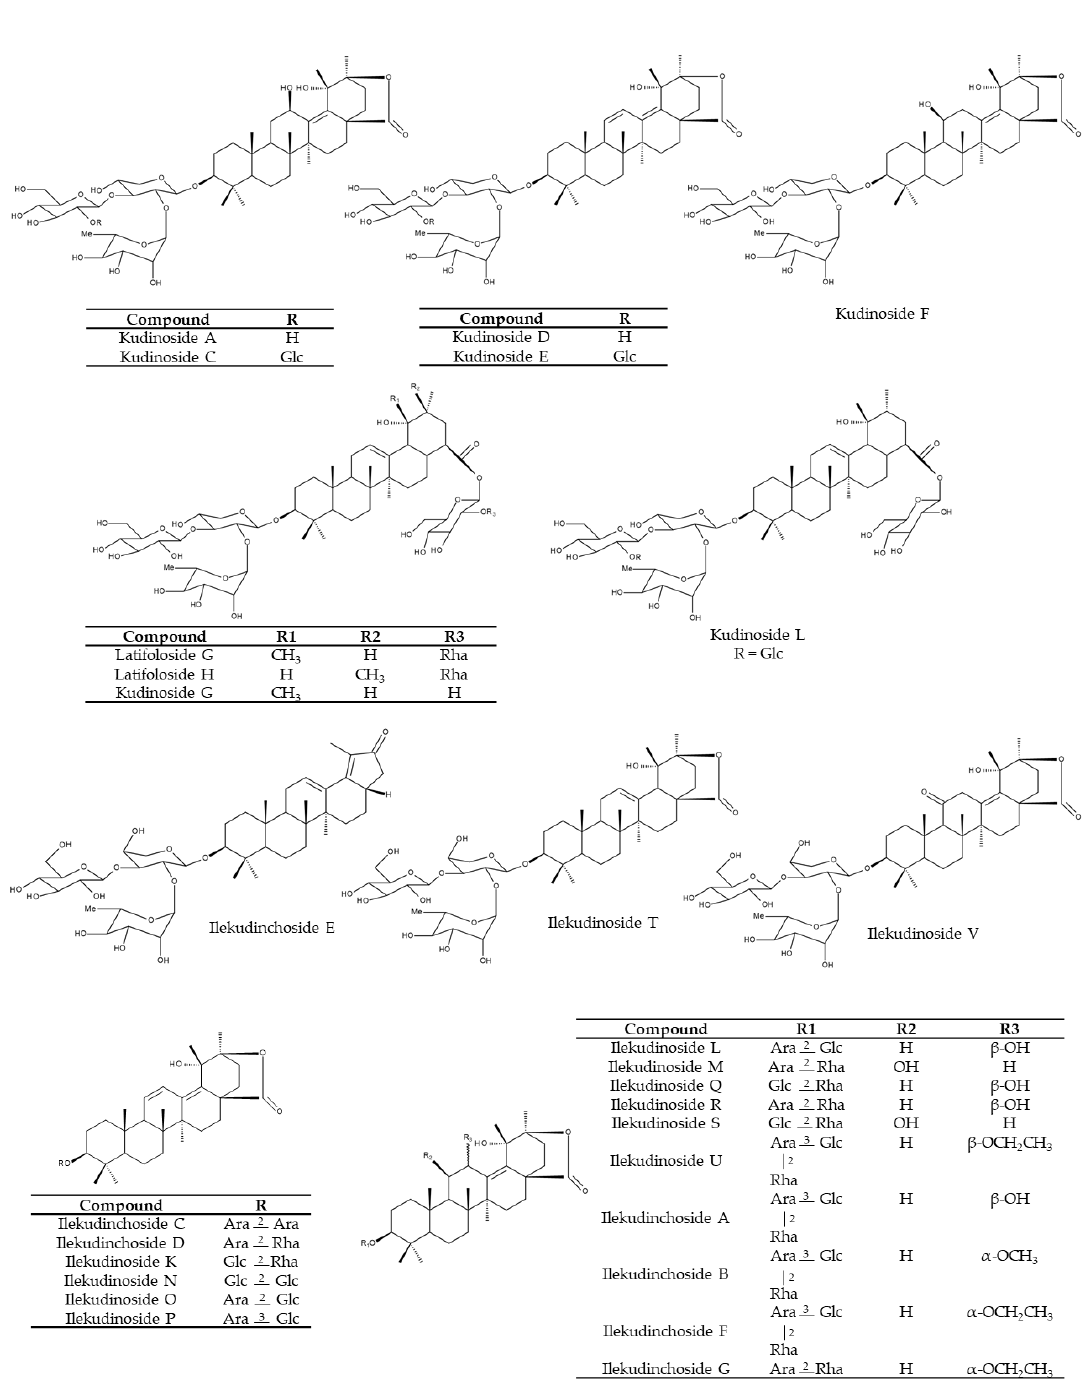
Figure 5. Chemical structures of the saponins in Kuding tea. Ara, arabinoside; Glc, glucoside; Rha, rhamnoside.